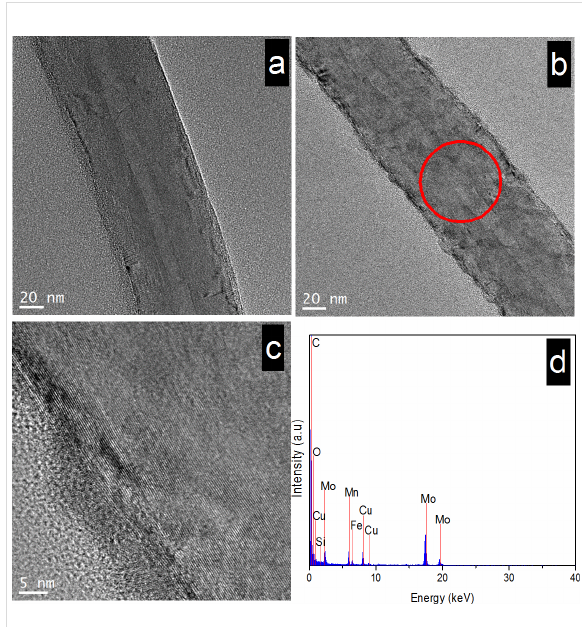
Figure 3: TEM and HRTEM images, as well as EDX spectrum of CNT - based samples: (a) CNTs, (b – d) 4% MnO 2 –CuO–Fe 2 O 3 /CNTs.